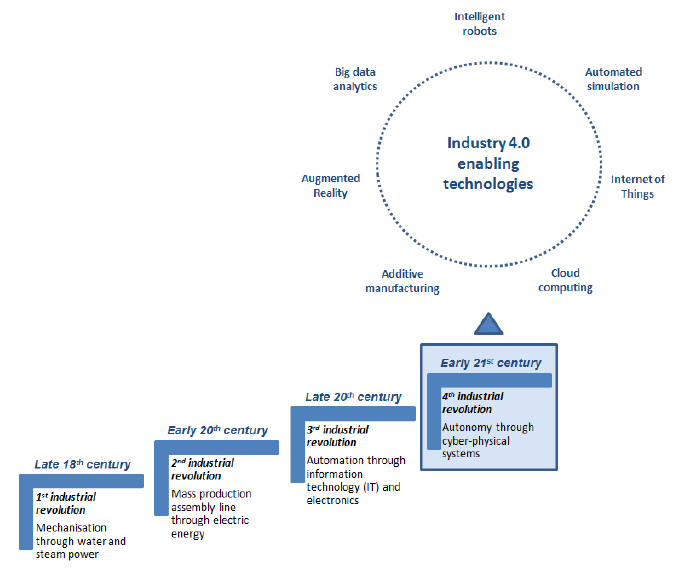
Figure 3. Industry 4.0 development timeline and enabling technologies.